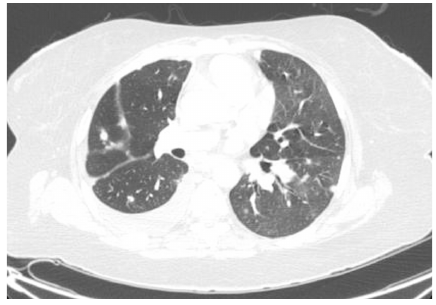
Figure 2: CT scan of chest showing a moderate right-sided pleural effusion, as well as bilateral pulmonary nodules with hilar